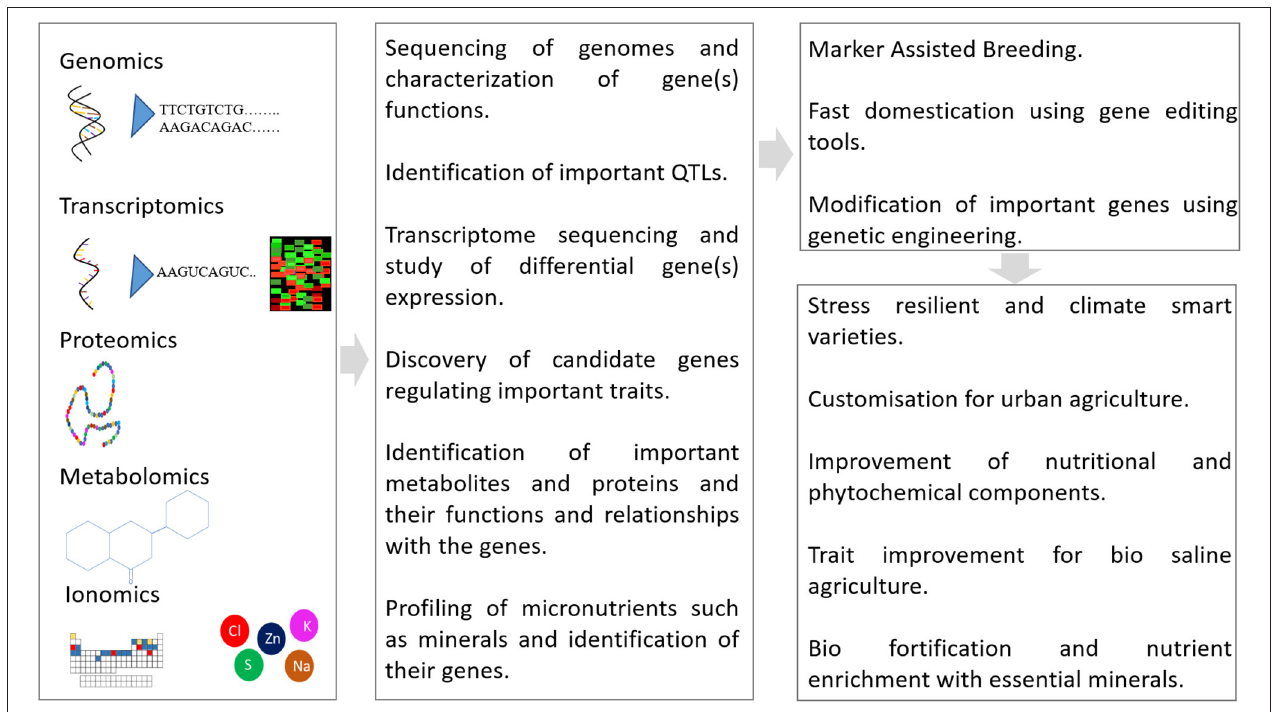
FIGURE 4 | Integrated strategies to improve purslanes using genomics and gene-editing